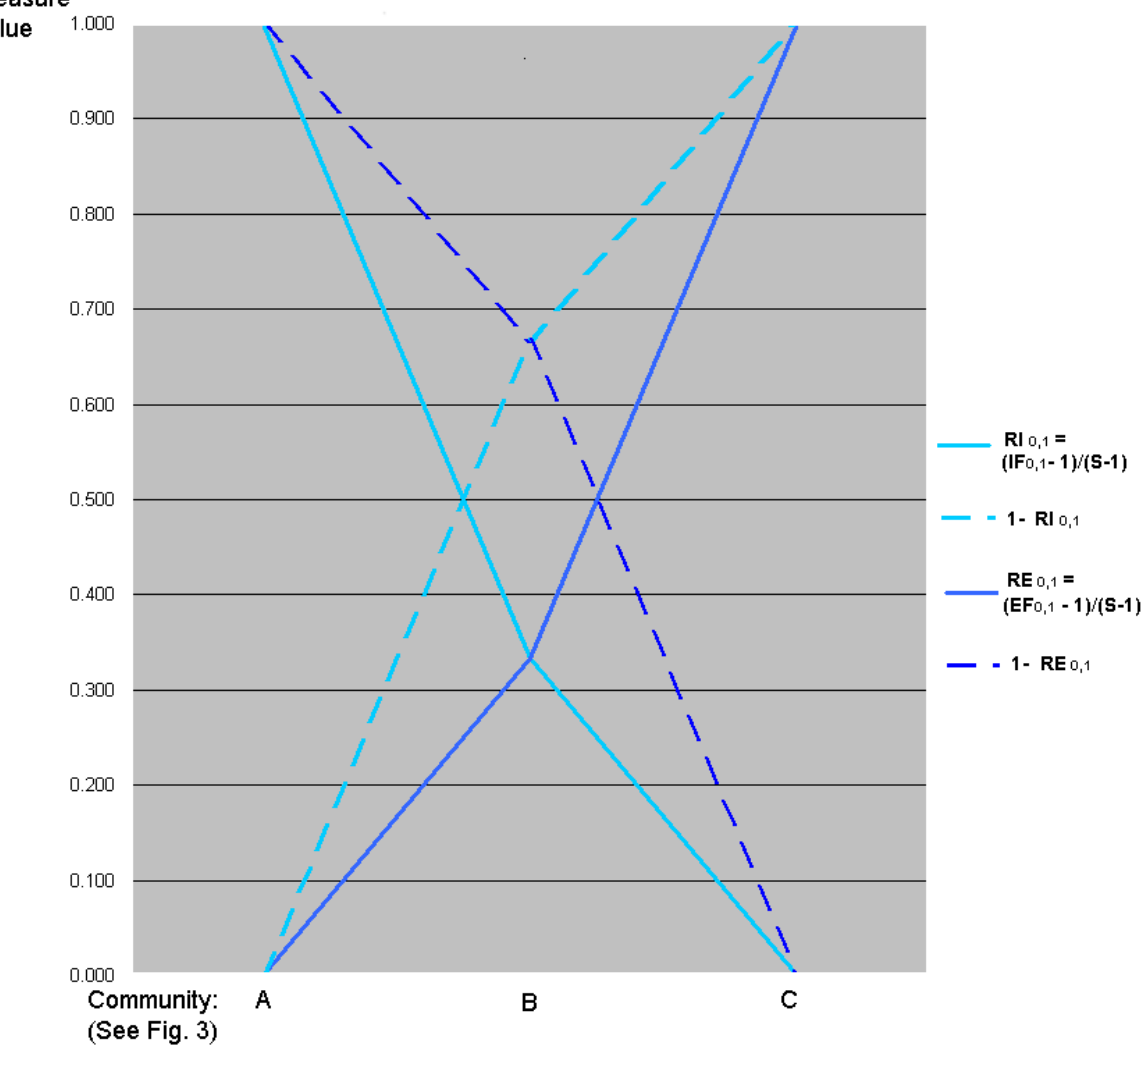
Figure 4. Non-complementarity of relative evenness RE RE and RI and their complements for Community A, Community B, and Community 0, 1 0, 1 C from Figure 3. RI and RE are not complements of each other. Compare Figure 0, 1 0, 1